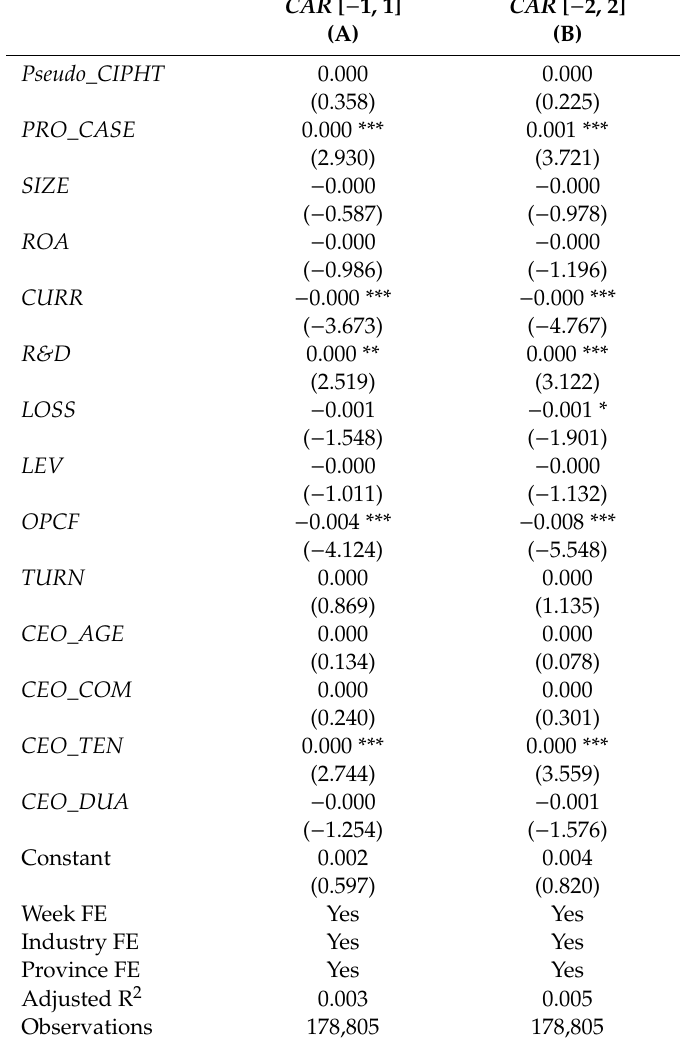
Table 6. Falsification